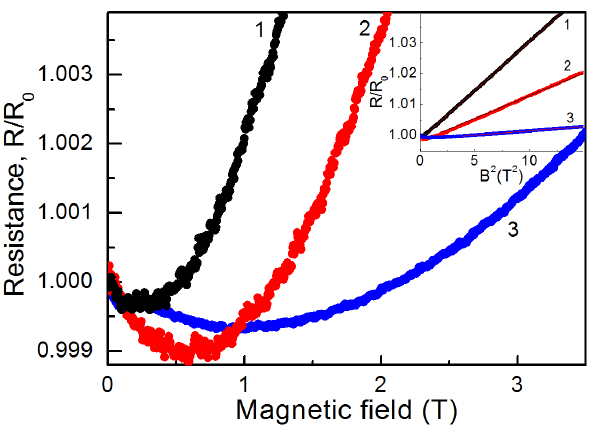
Figure 6. Temperature dependence of conductivity G for structures with different thicknesses of epitaxial films. Left panel:29 nm thick film; right panel:53 nm thick film. The numbers next to the experimental curves correspond to the electron exposure time measured in minutes.